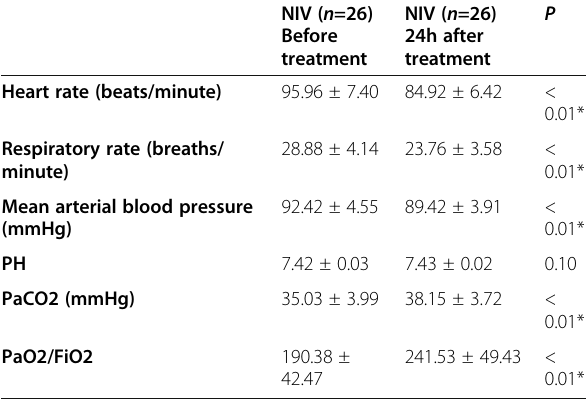
HFNCO high flow nasal cannula oxygen, NIV non-invasive ventilation, PaCO2 arterial pressure of carbon dioxide, PaO2 arterial pressure of oxygen, FiO2 fraction of inspired oxygen Significance at * P <0.05